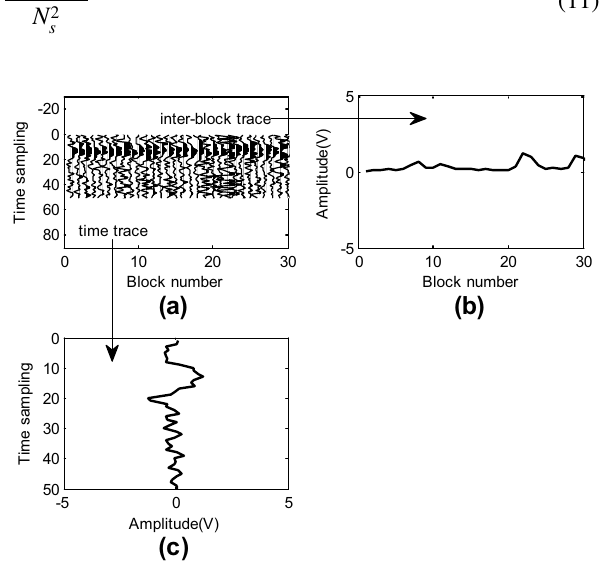
Fig. 5 a A group of pure signal. b Channel along inter-block direc- tion. c Channel along time